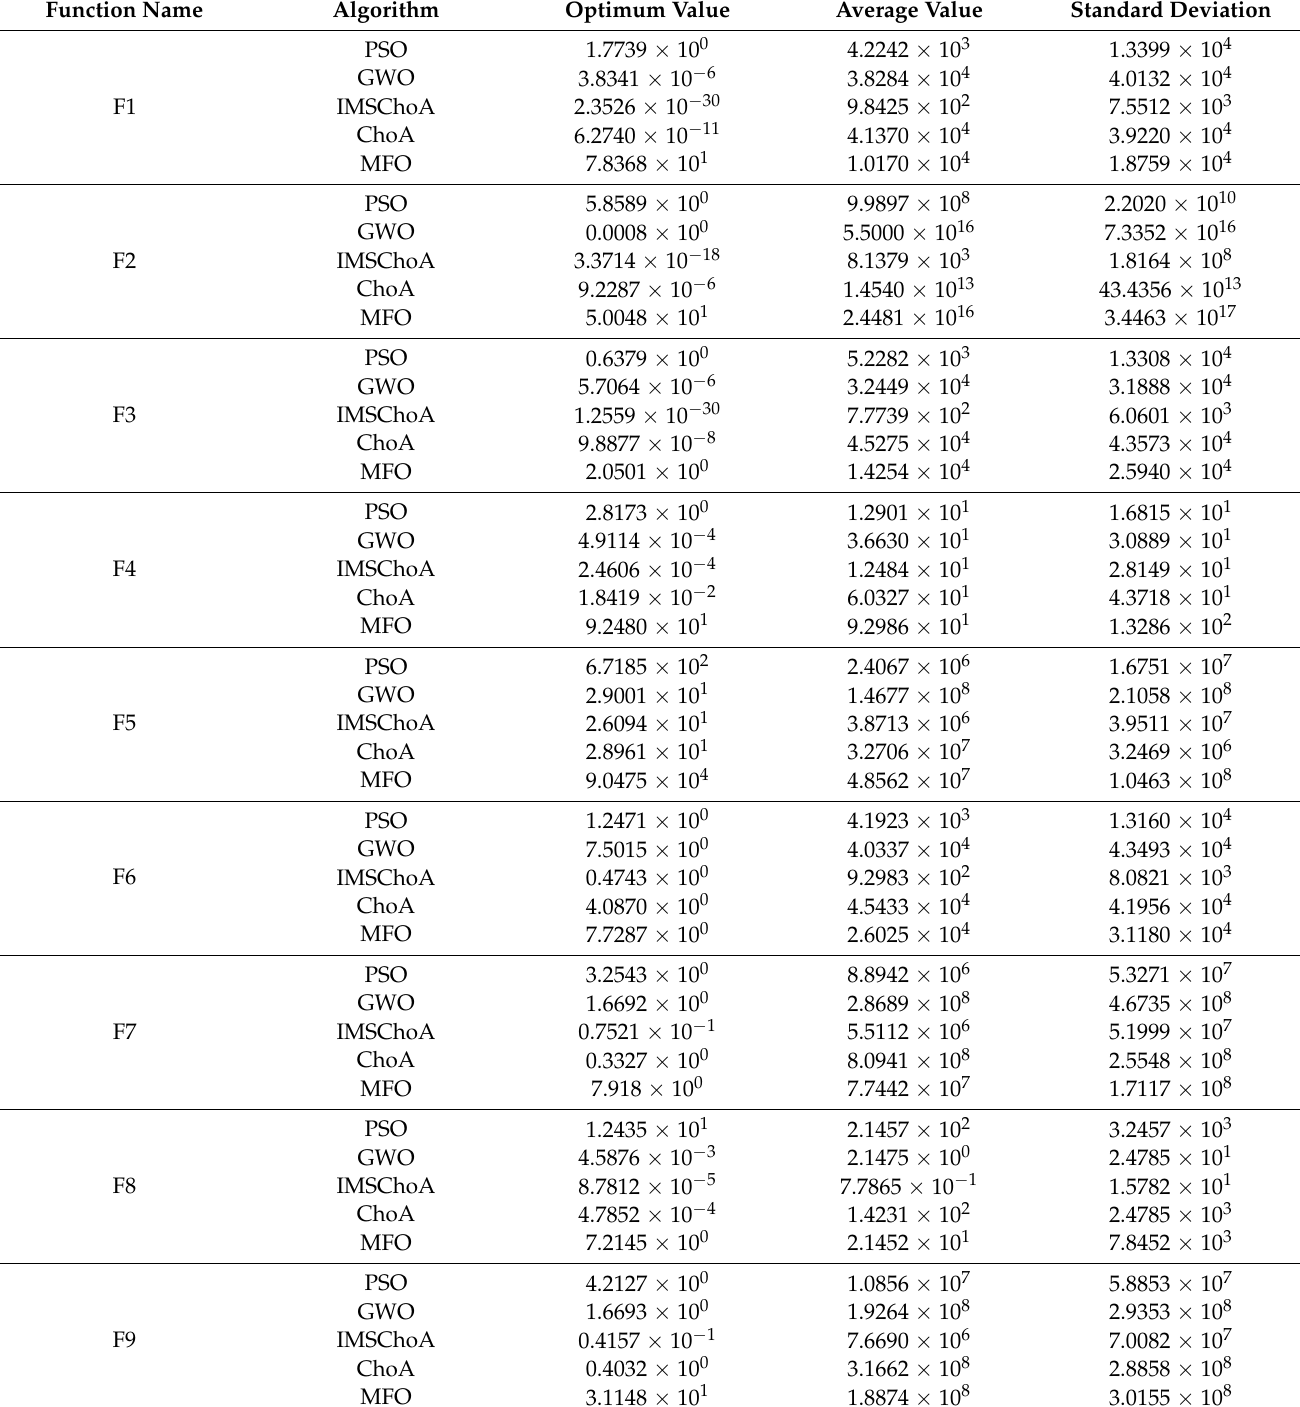
Table 3. Experimental results of function test (30